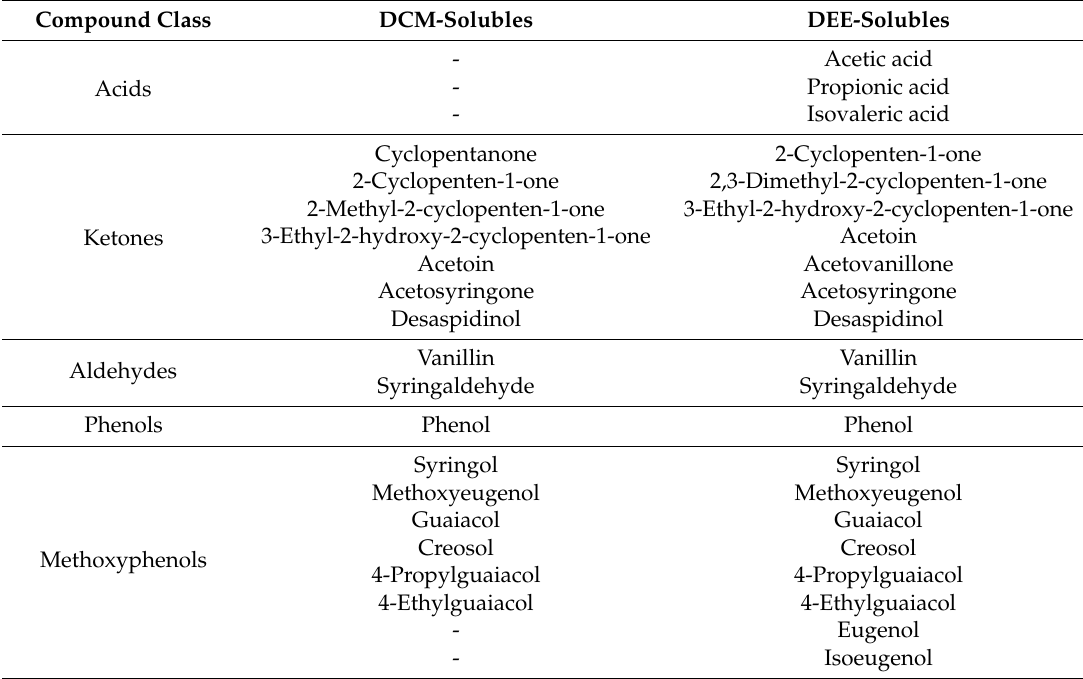
Table A1. Comparison of GC-MS identified compounds between DCM and DEE-solubles in BC1 (experiments carried out at 300 ◦ C-10 min-10% with Procedure 1).